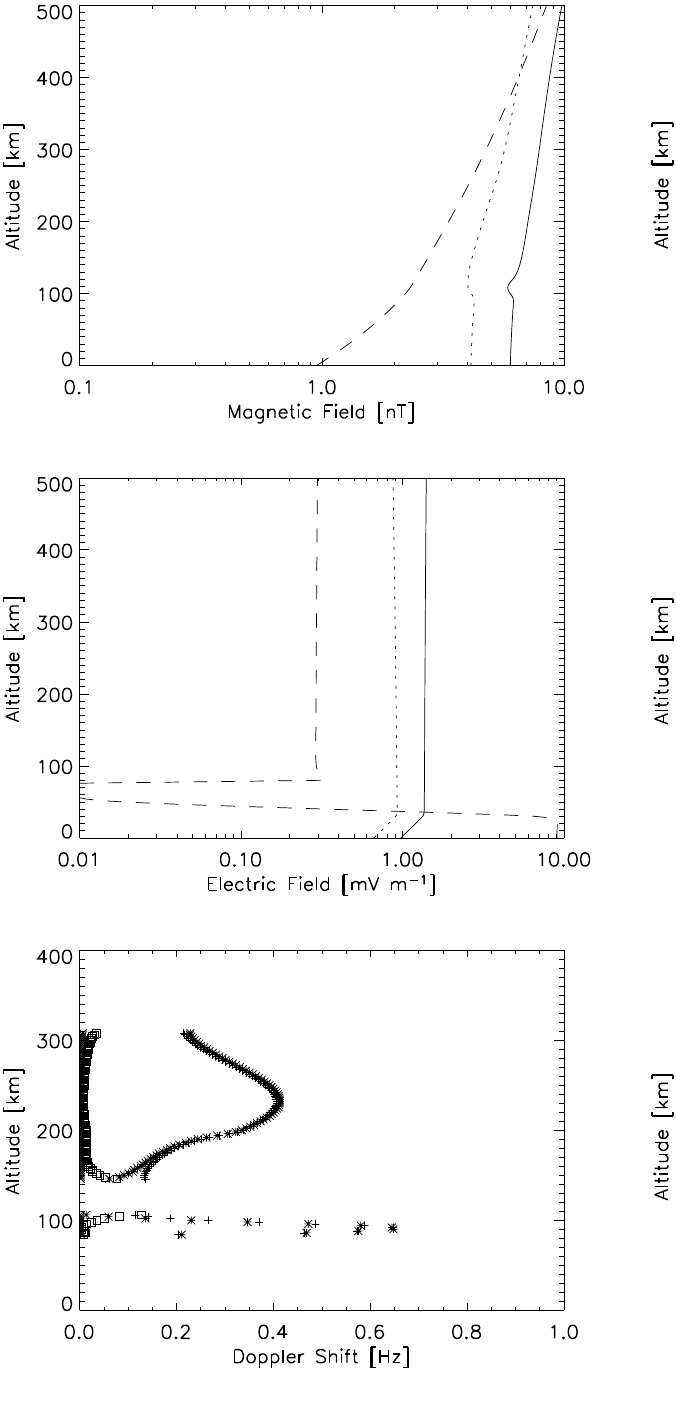
Fig. 7. Model results of the ULF electric and magnetic fields and the associated Doppler shift with altitude. The parameters associ- ated with 16:00–18:00 UT, 25 March 2002 were used. (a) ULF wave magnetic field magnitudes where b x (solid), b y (dotted), b z (dashed). (b) ULF wave electric field magnitudes where e x (solid), e y (dotted), e z (dashed). (c) Doppler shifts where V 1 (X), V 2 (+), V 3 (squares) and V ∗ (*).